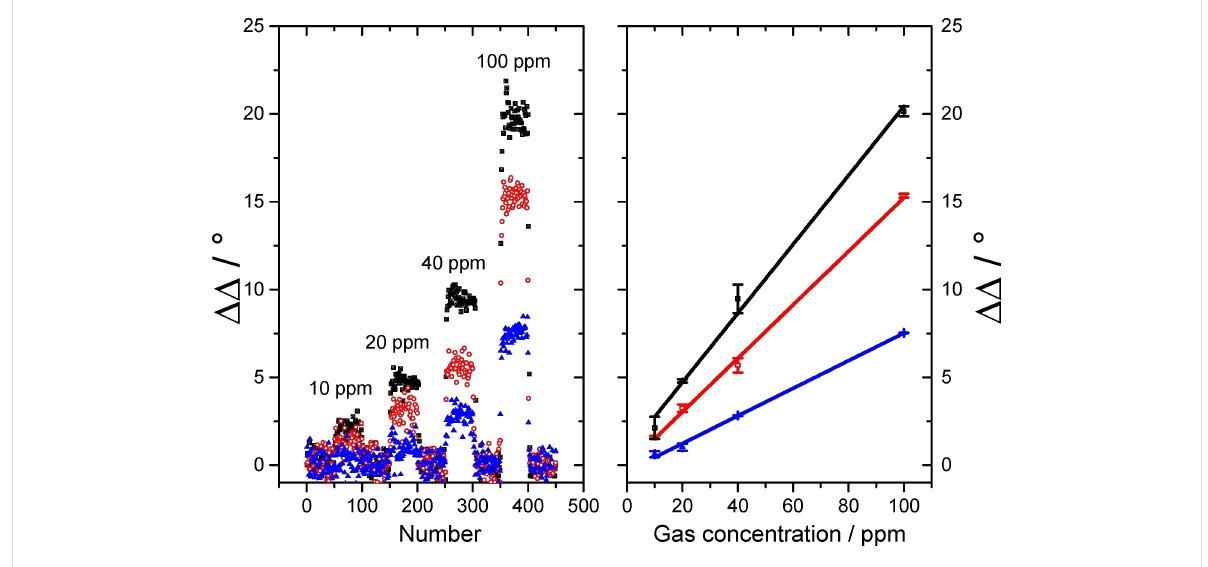
Figure 6: Gas measurement of C 3 H 8 (black rectangle), CO (blue triangle) and H 2 (red dots) with SPREE with an undoped SnO x layer at an AOI of 45.3° (left). Linearity analysis of the ΔΔ response to the gas concentration (right).